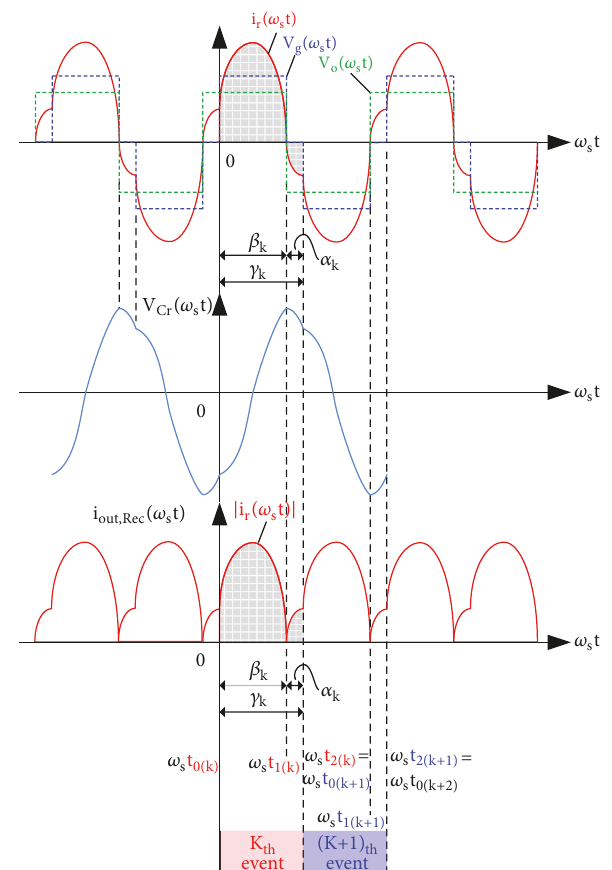
Figure 5: Resonant inductor current and resonant capacitor voltage waveforms of SRC# in subresonant CCM.